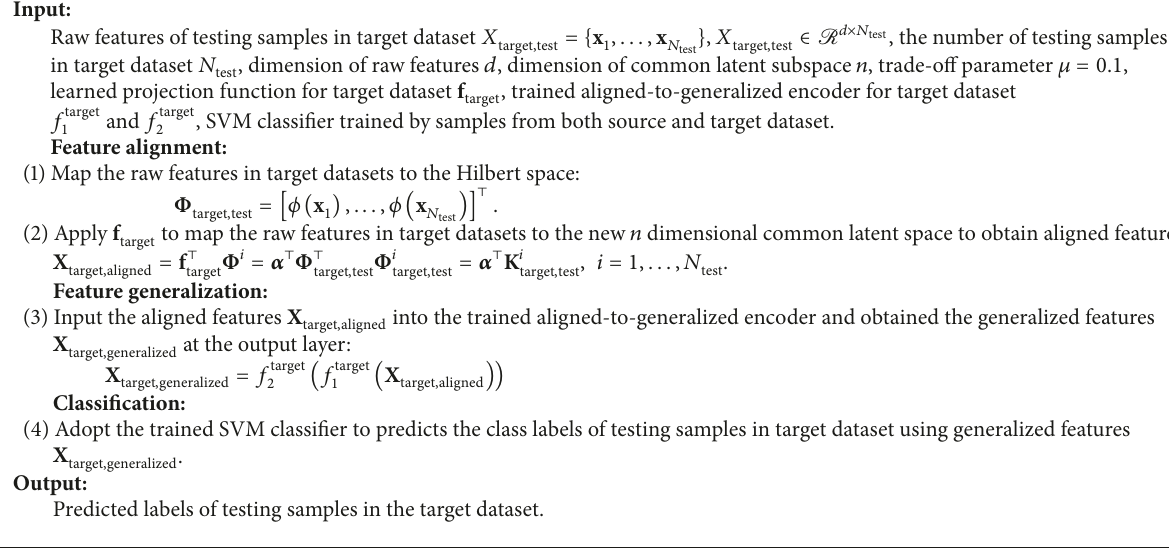
Algorithm 2: Testing algorithm of CDFAG.